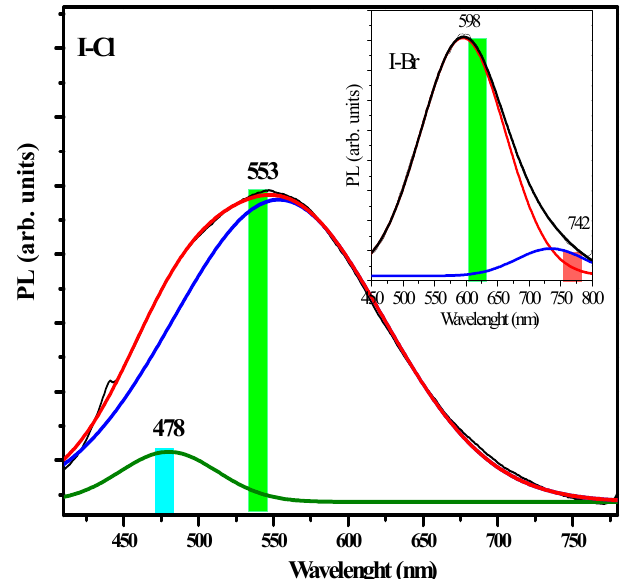
Figure 11. Photoluminescence deconvolution of the Gaussian corresponding to I − Cl spectra. The inset shows the deconvolution corresponding to the I − Br sample.